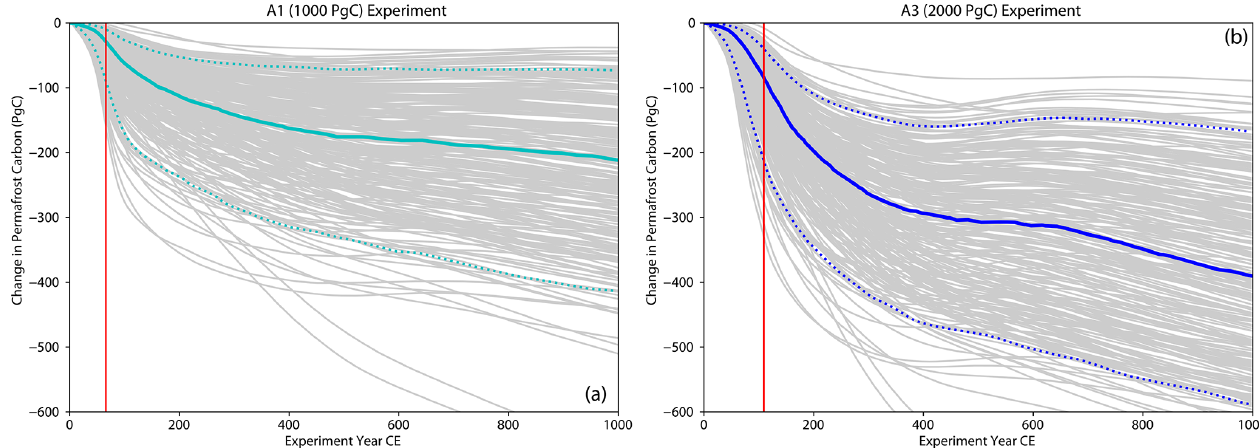
Figure 6. Change in the soil carbon held in permafrost regions relative to pre-industrial size. (a) Change for the A1 (1000PgC) experiment. (b) Change for the A2 (2000PgC) experiment. Grey lines are individual model variants, solid line is the median of the variants, and dashed lines are the 5th and 95th percentile. Vertical red line marks the time emissions cease.